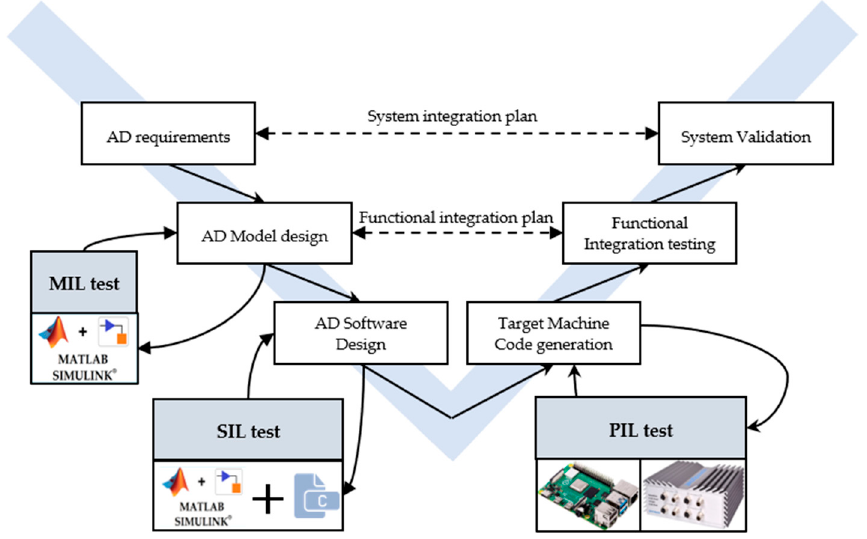
Figure 5. V-cycle process for software development.